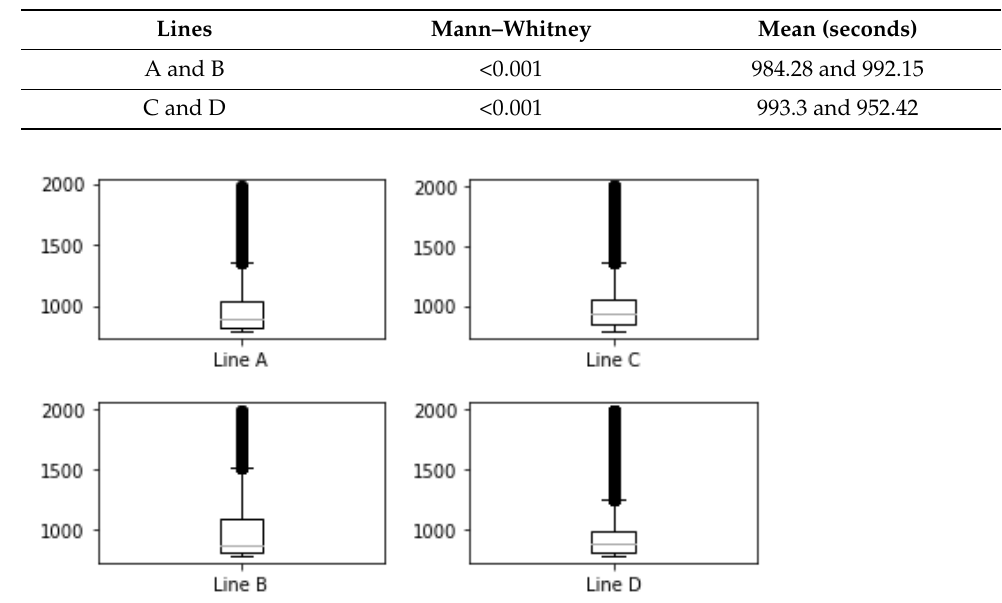
Figure 3. Boxplot for the cycle time (in seconds), per line.